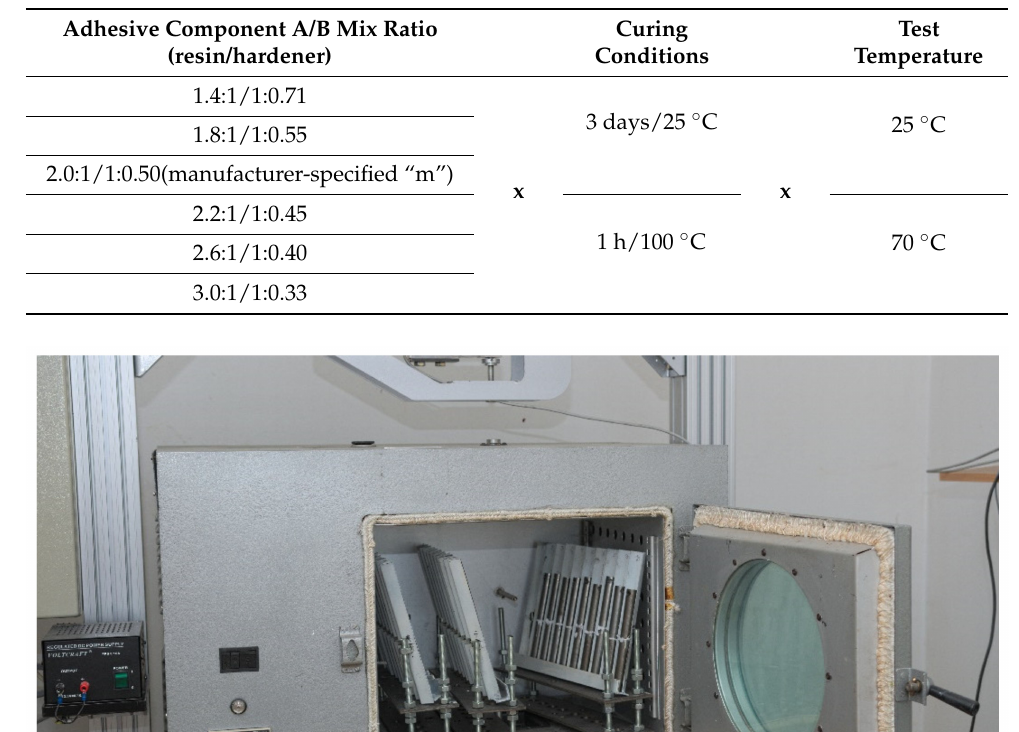
Table 1. Experimental test plan.